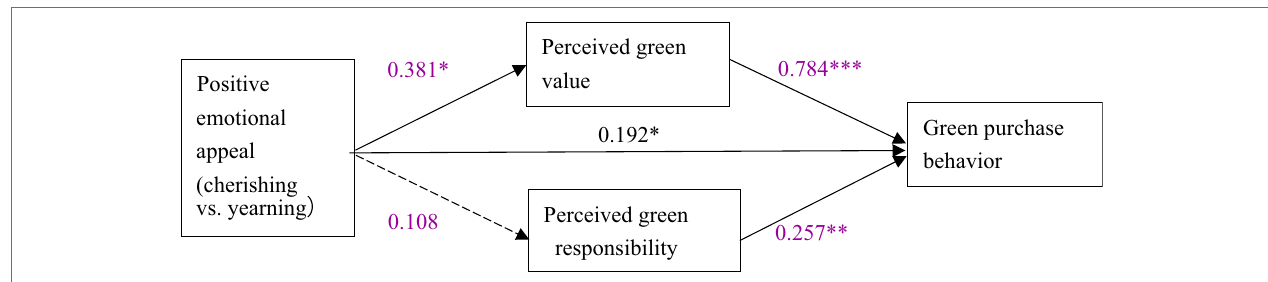
FIGURE 5 | Mediating effect test (cherishing vs. yearning). * p < 0.05; ** p < 0.01; *** p < 0.001.